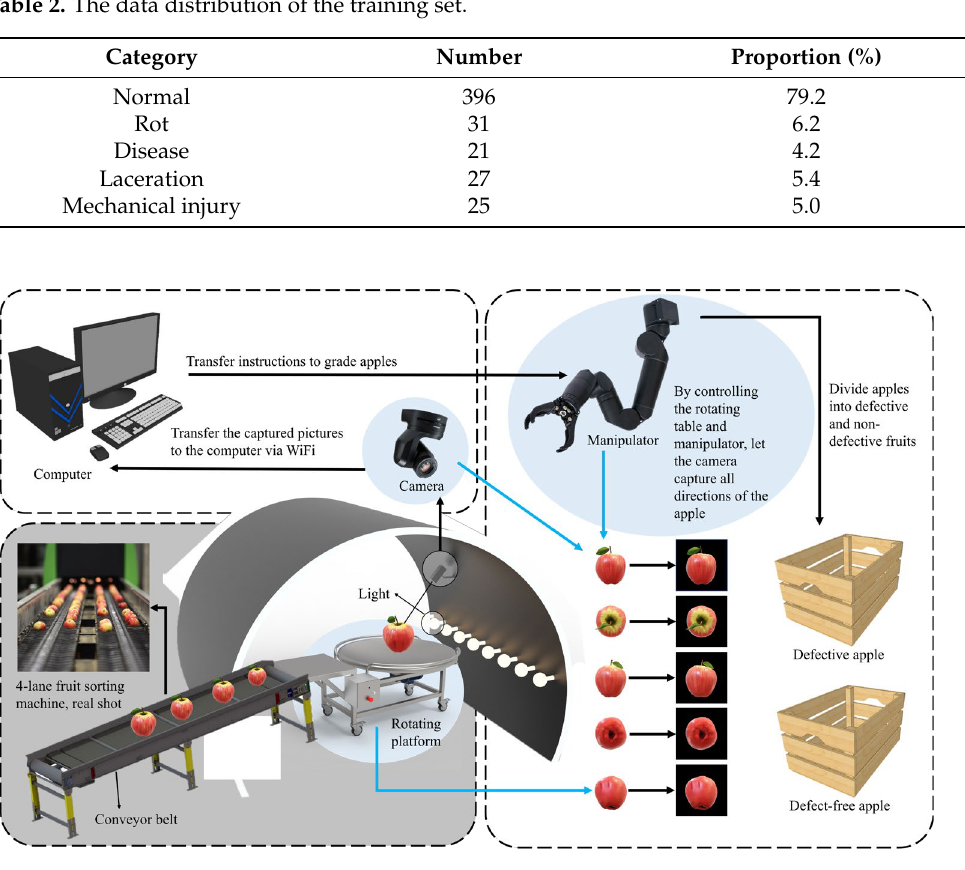
Figure 1. Schematic diagram and physical photos of the optical chamber of the 4-channel fruit sorting